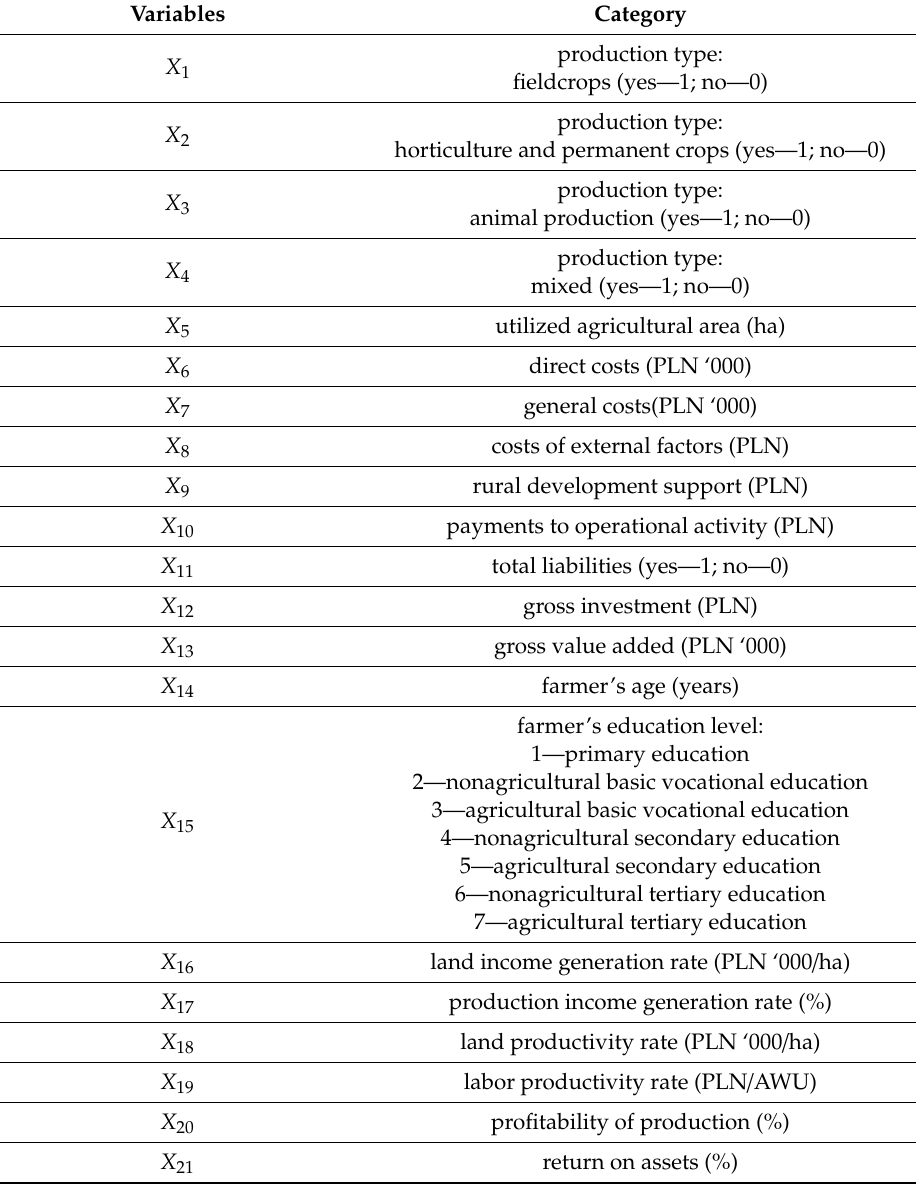
Table 1. Set of variables applied in the